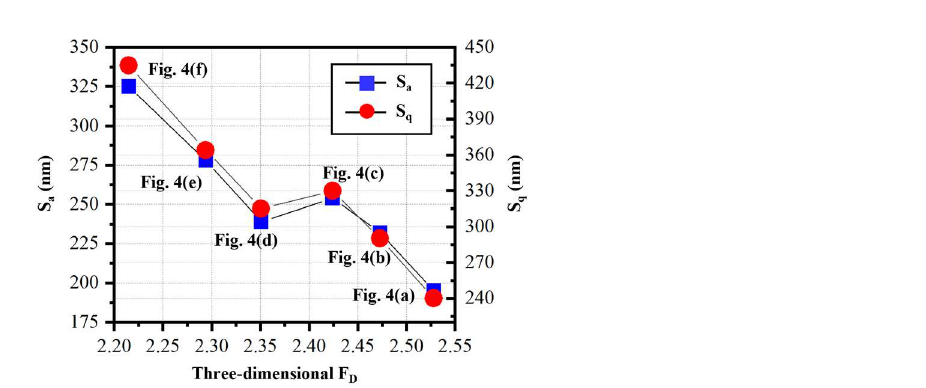
Figure 6. Surface roughness of the micro-milled KDP surfaces versus the calculated 3D fractal di- mension.